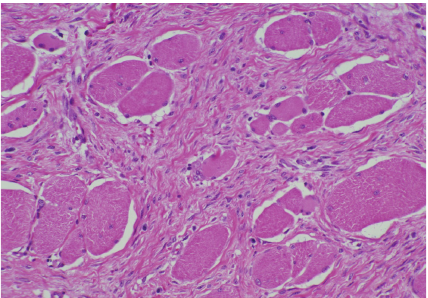
Figure 1: Abdominal wall mass arising from the right rectus abdominis.